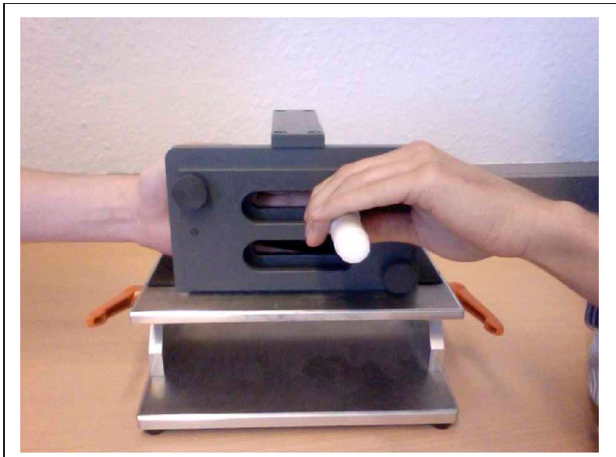
FIGURE 1 | The stimulating device. The left hand is inside the stimulator. The experimenter’s left hand (for EA) (or the participant’s right hand for SA) is moving a white plastic pointer with a spherical tip of 1mm diameter which is counterweighted with a spring to maintain a constant pressure of 0.17 N at the stimulated finger. The device is designed in a way that the tip touches the palmar side of only one finger